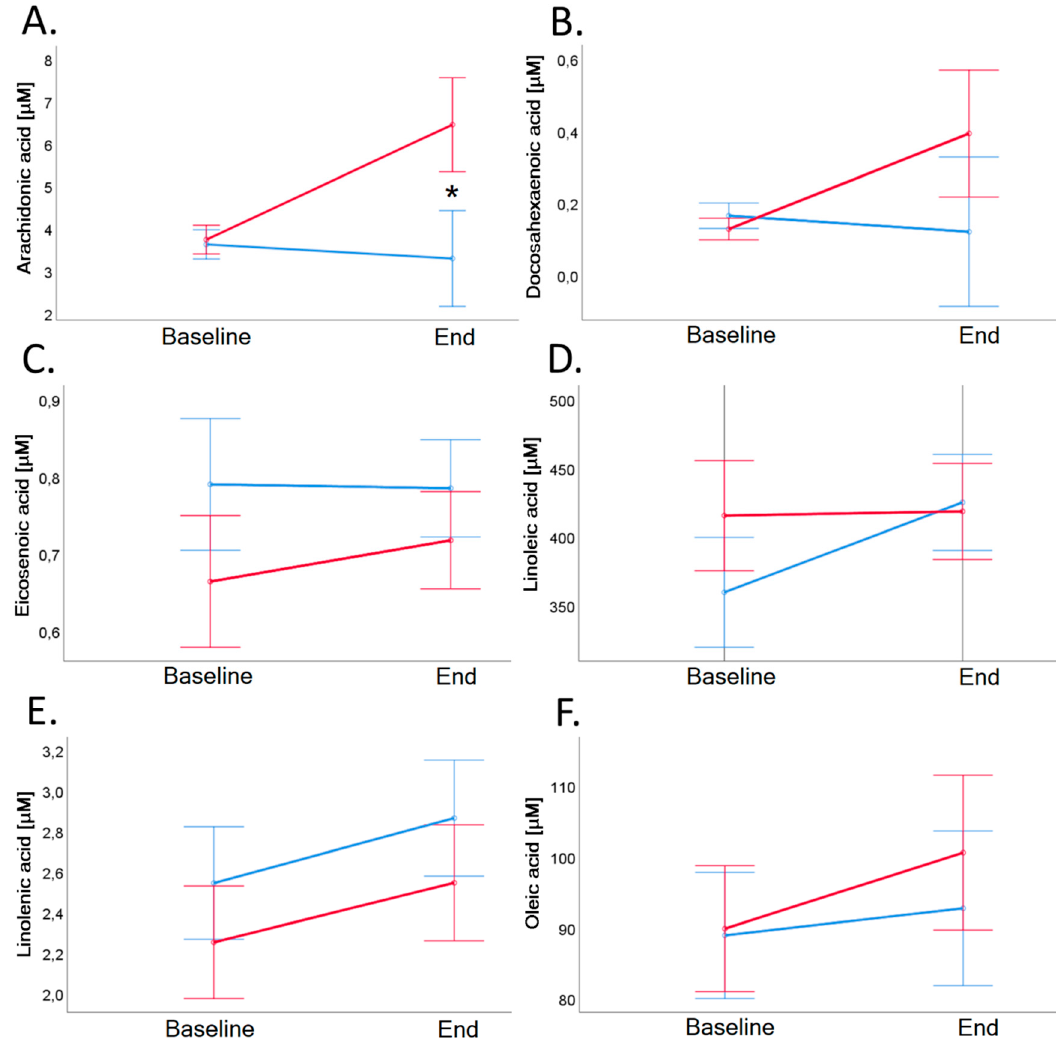
Figure 8. Arachidonic acid (Panel A ), docosahexaenoic acid (Panel B ), eicosenoic acid (Panel C ), linoleic acid (Panel D ), linolenic acid (Panel E ), and oleic acid (Panel F ) in serum before and after 4-week dietary intervention in VD (blue line) and MD (red line). Baseline value of arachidonic acid of MD group was 3.7 ± 1.8 µM and increased significantly to 6.4 ± 8.0 µM ( p = 0.021), arachidonic acid of VD group remained stable ( p = 0.424). Error bars show ± 1 standard error. Baseline and end values as well as statistical comparisons are shown in Table 3. Significant differences between groups are marked with an asterisk (*: p < 0.05).